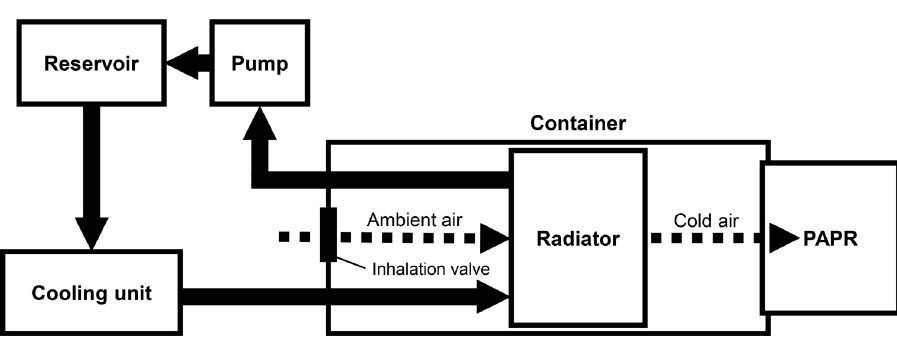
Fig 1. Diagram of the cooling device developed in this study. PAPR: powered air-purifying respirator.